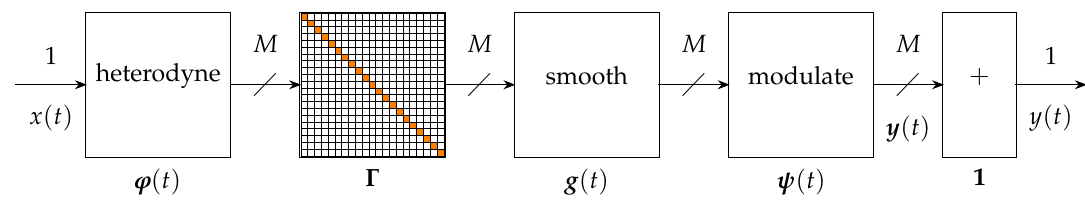
Figure 3. Basic modal reverberator architecture. The modal reverberator is the parallel combination of resonant filters matched to the modes of a linear system.